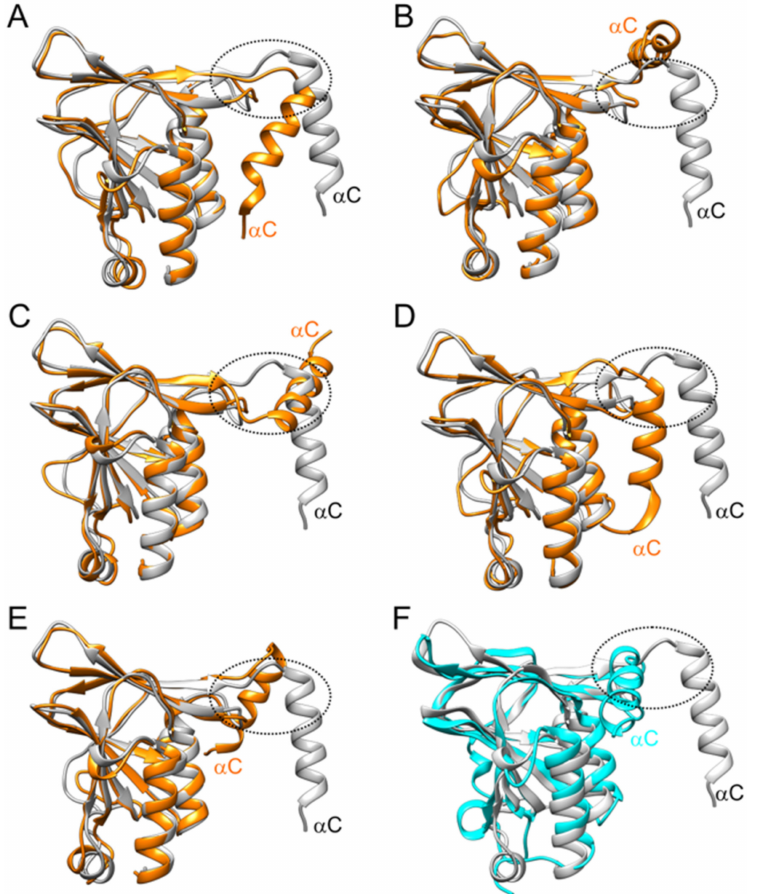
Figure 6. Conformational plasticity of pUL50 in the absence of pUL53. ( A – E ) Overlay of the pUL50 conformation present in the NEC (grey) with representative structures observed during the molecular dynamics simulations (orange) highlighting the conformational flexibility of helix α C. A dotted circle marks the region that is involved in the pUL50–pUL50 (cid:48) interactions in the hexameric NEC (see Figure 5B for details). ( F ) Overlay of the pUL50 conformation in the NEC (grey) with the conformation observed for the unbound MCMV pM50 (cyan). The relevant structures were obtained from the PDB (codes 5D5N and